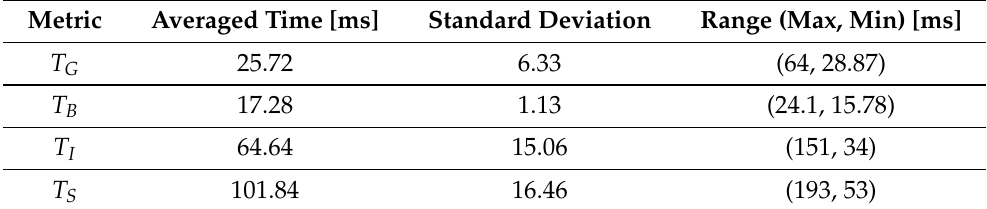
Table 5. Experimental Results.